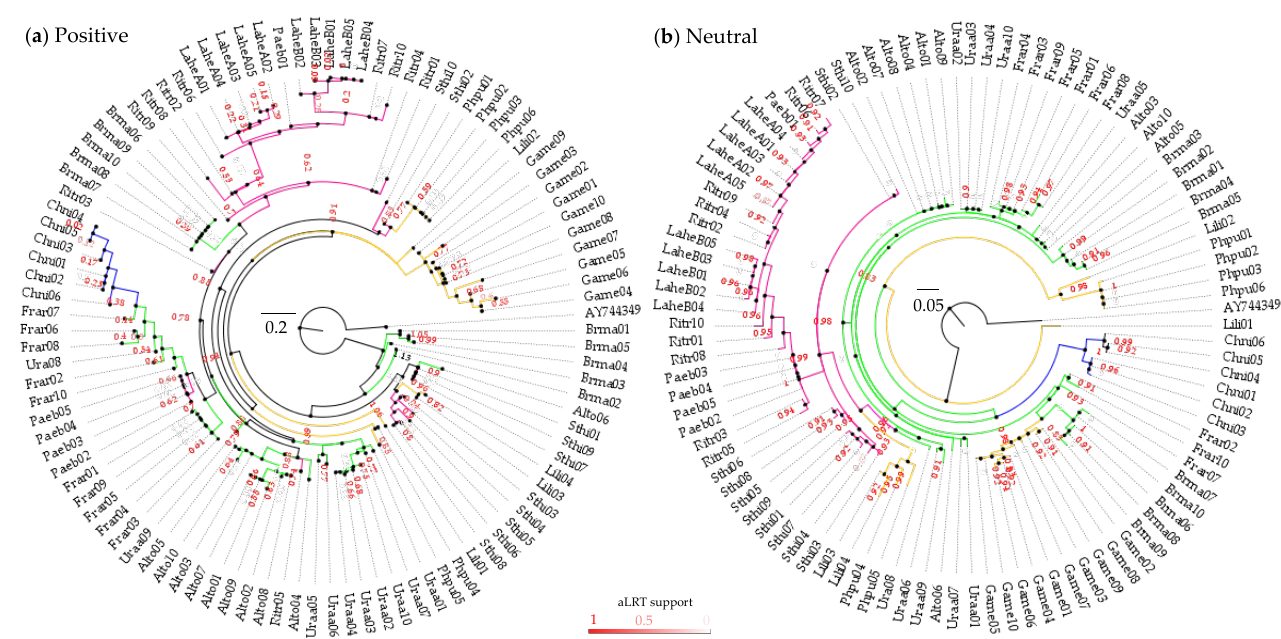
Figure 7. Maximum likelihood phylogenetic trees for MHCIIB alleles in Charadriiformes were inferred using positive ( a ) and neutral ( b ) codons, separately. Branch colors correspond to the family (magenta—Laridae; green—Alcidae; yellow—Scolopacidae; blue—Charadriidae). Labels in each branch show the sequences belonging to the species analyzed (i.e., Lahe = Larus heermanni ; see